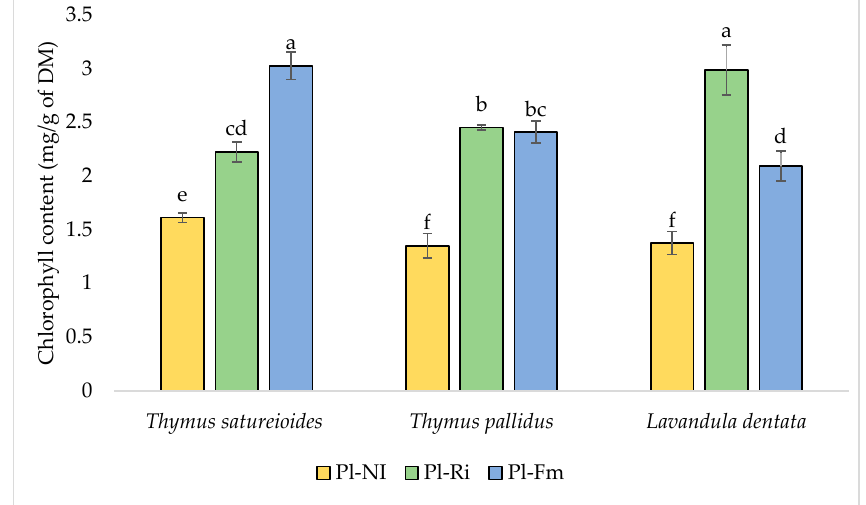
Figure 3. Chlorophyll content (mg/g DM) in Thymus satureioides (Ts), Thymus pallidus (Tp), and Lavandula dentata (Ld), non-inoculated (NI) or inoculated with Rhizophagus irregularis (Ri) or Funneliformis mosseae (Fm) after 4 months of culture under greenhouse conditions Bars followed by the same letter are not significantly different according to Tukey’s HSD test ( p < 0.05). The total soluble sugar content significantly increased ( p < 0.0001) in I-AMP com- pared to their respective NI-AMP, regardless of the AMF strain or AMP species used. It varied between 62.2 and 185, 108.7 and 141.9, and 156 and 163.9 mg/g DM in mycorrhizal plants of T. satureioides , T. pallidus , and L. dentata , respectively, and did not exceed 30.7, 48.3, and 99.8 mg/g DM in their corresponding NI-AMP. The total soluble sugar content was 6 times higher in Ts-Fm, 2.2 times higher in Tp-Ri, and 1.5 times higher in Ld-Ri and Ld-Fm compared to NI-AMP (Figure 4). Figure 4. Soluble sugar content (mg/g DM) in Thymus satureioides (Ts), Thymus pallidus (Tp), and Lavandula dentata (Ld), non-inoculated (NI) or inoculated with Rhizophagus irregularis (Ri) or Fun- neliformis mosseae (Fm) after 4 months of culture under greenhouse conditions. Bars followed by the same letter are not significantly different according to Tukey’s HSD test ( p < 0.05).